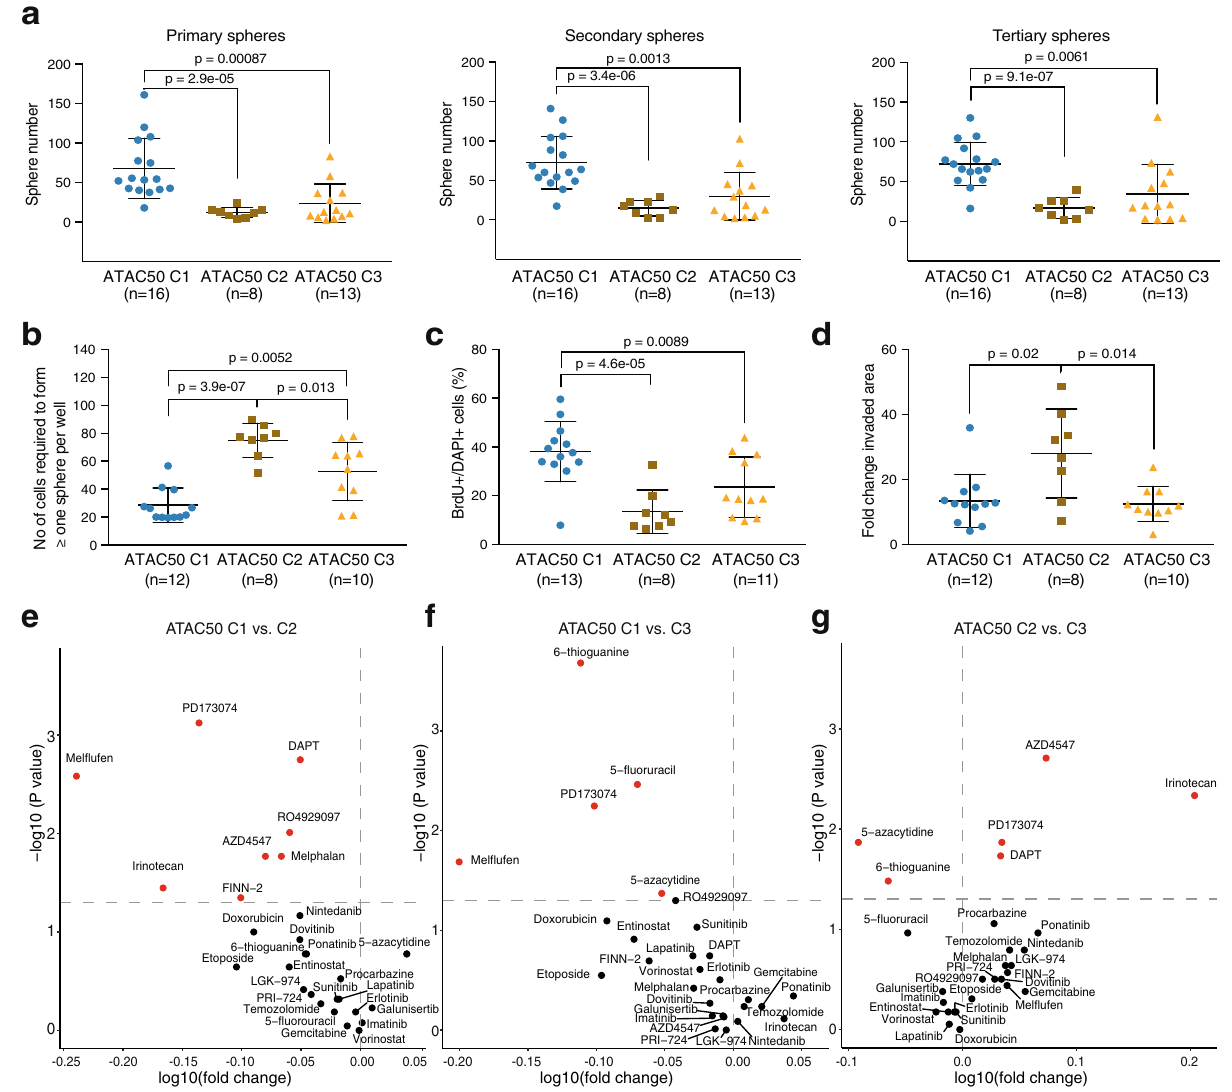
Fig. 5 ATAC50 produces functional separation of hGSC cultures. a Consecutive sphere assays comparing ATAC50 clusters. Primary spheres (left), secondary spheres (middle), and tertiary spheres (right). b ELDA comparing ATAC50 clusters. c Frequency of BrdU-positive cells. Data show mean ± SEM. d Collagen invasion assay measuring the invaded area at 24 h. Data show mean ± SEM. a – d Data show mean ± SEM. Two-sided Welch ’ s t -test was performed on all pair-wise comparisons, and signi fi cant differences are indicated with p value. n number of cell cultures. e – g Volcano plots of pair-wise comparisons of AUC scores in ATAC50 C1 ( n = 12), C2 ( n = 7), and C3 ( n = 10) cultures to 28 anticancer drugs. Red circles indicate signi fi cantly different drug response. n , number of cell cultures. Two-sided Mann – Whitney was performed on all pair-wise comparisons without multiple adjustment. e ATAC50 C1 versus C2. Red circles in upper left corner, C1 more sensitive. f ATAC50 C1 versus C3. Red circles in upper left corner, C1 more sensitive. g ATAC50 C2 versus C3. Red circles in upper left corner, C2 more sensitive. Red circles in upper right corner, C3 more sensitive. Source data are provided as a Source Data fi le for Fig. 5a –